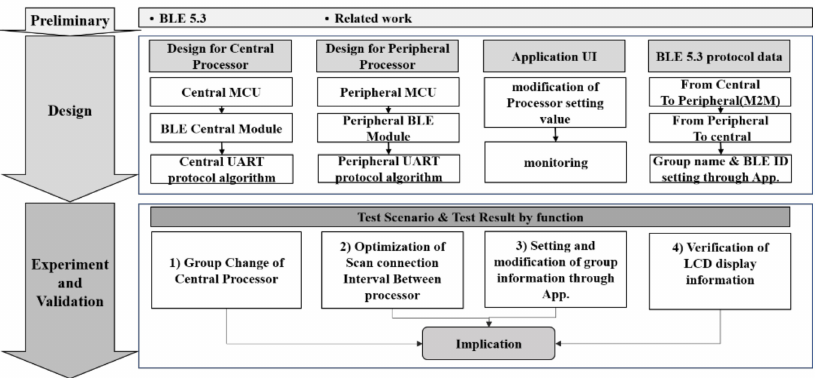
Figure 2. Research process.